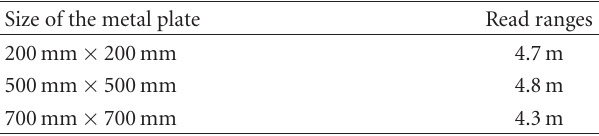
Table 2: Tag performance testing results with the tag attached on di ff erent metal